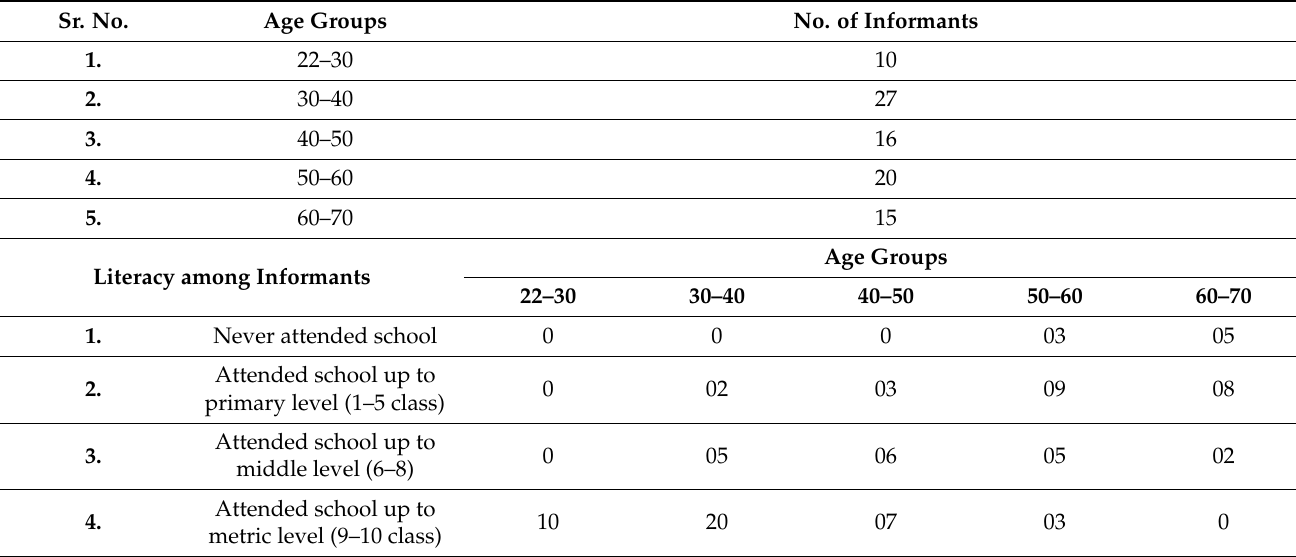
Table 1. Demography and literacy among